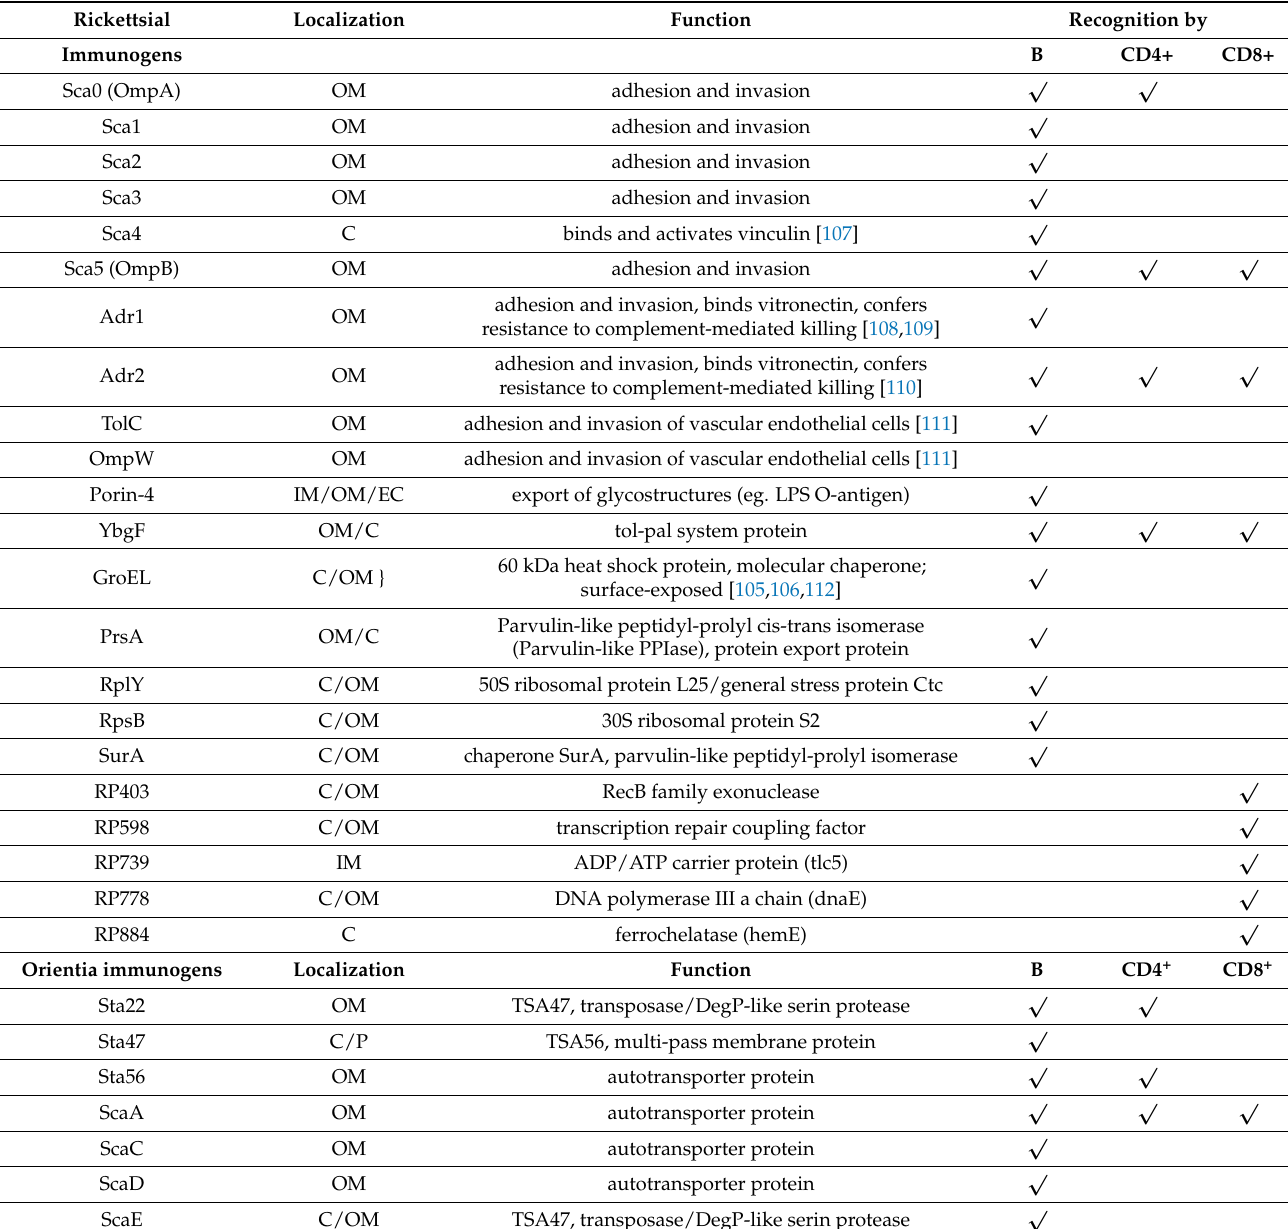
Table 2. Overview on experimentally identified rickettsial immunogens, their localization, and recognition by B and/or T cells. The table provides an overview of so-far-known antigens from rickettsiae and orientia, their localization and function, and whether they are recognized by B and/or T cells. OM: outer membrane, IM: inner membrane, C: cytoplasm, P: √ periplasm, EC: extracellular, : experimentally proven recognition. Empty fields: not described.